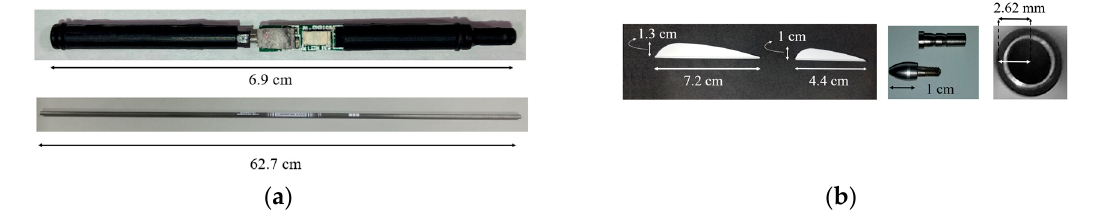
Figure 1. ( a ) Superior part: acceleration sensor, bottom: arrow shaft; ( b ) left: two straight vanes, center: screw-in point with insert, right: cross-sectional view of the arrow’s